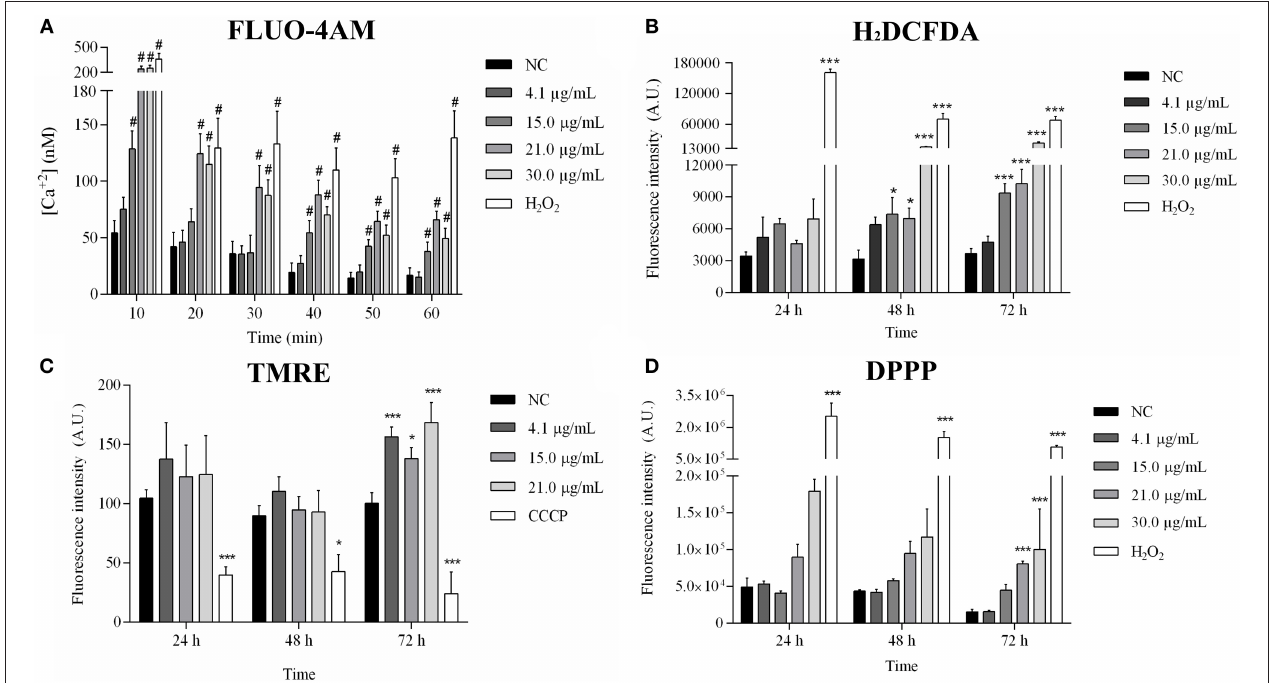
FIGURE 6 | Mitochondrial profile analysis after 24, 48, and 72h of exposition to sugiol. (A) Cytosolic calcium level in promastigotes treated with different concentrations of sugiol detected by FLUO-4AM molecule; (B) ROS production detection by H 2 DCFDA; (C) mitochondrial membrane potential evaluated using TMRE label; (D) detection of lipid peroxidation by DPPP label. Fluorescence was measured in arbitrary units (A.U.) using Perkin Elmer Victor-X3 fluorometer. H 2 O 2 and CCCP were used as positive control. The results were expressed in the bar graphs as the mean ± SD of three independent experiments. * p < 0.05 and *** / # p < 0.001, significant difference compared to negative control (NC)